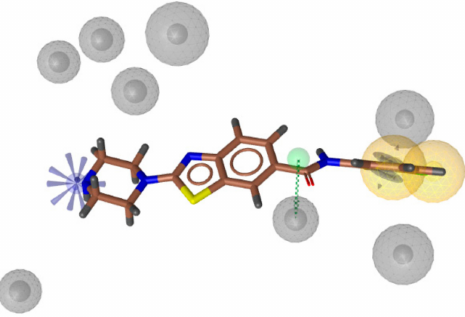
Figure 3. Alignment of a representative compound (R, 3-Cl) of the general structure E (brown sticks) with the three-dimensional structure-based pharmacophore model derived from molecular dynamics simulation of a coumarin-based Hsp90 CTD inhibitor in complex with Hsp90 β [32]. The pharmacophores included two with hydrophobic features (yellow spheres), one with an aromatic (blue disc), a hydrogen bond (H-bond) donor (green arrow, indicating the defined direction for H- bonding), and a positive ionizable (blue star). The exclusion volumes (grey spheres) define restricted regions based on the shape of the aligned